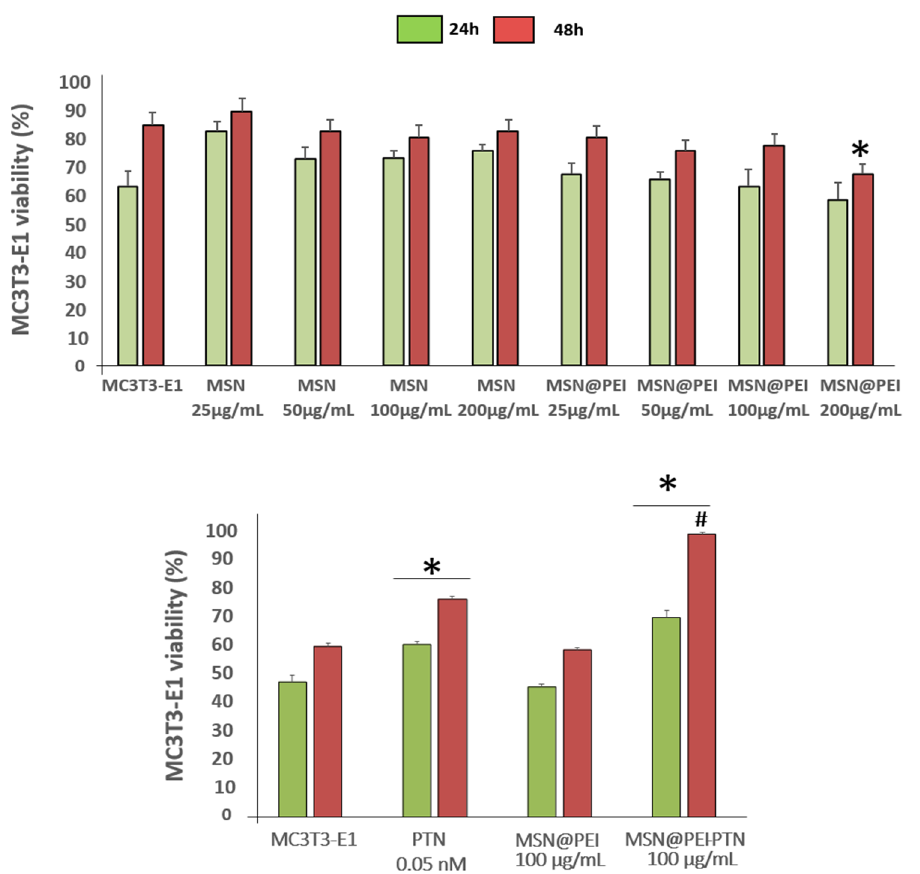
Figure 4. Mouse pre-osteoblastic MC3T3-E1 cell viability (measured by Alamar Blue ® ) in contact with different concentrations of MSN and MSN@PEI loaded or not with pleiotrophin (PTN) or in the presence of 0.05 nM exogenous PTN alone at 24 and 48 h of cell culture. Data are mean ± SEM of three independent experiments performed in triplicate. * p < 0.05 vs. MC3T3-E1 cells and MSN@PEI 100 μ g/mL; # p < 0.01 vs. PTN 0.05 nM and all groups .